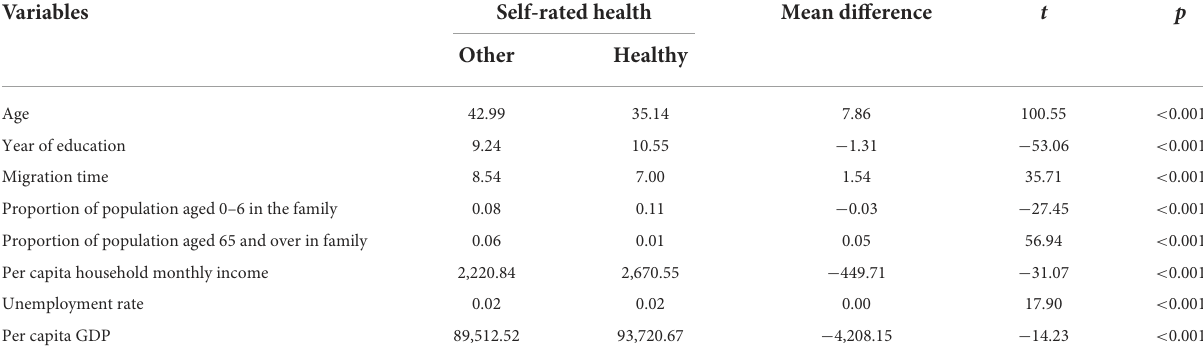
TABLE 3 Univariate test